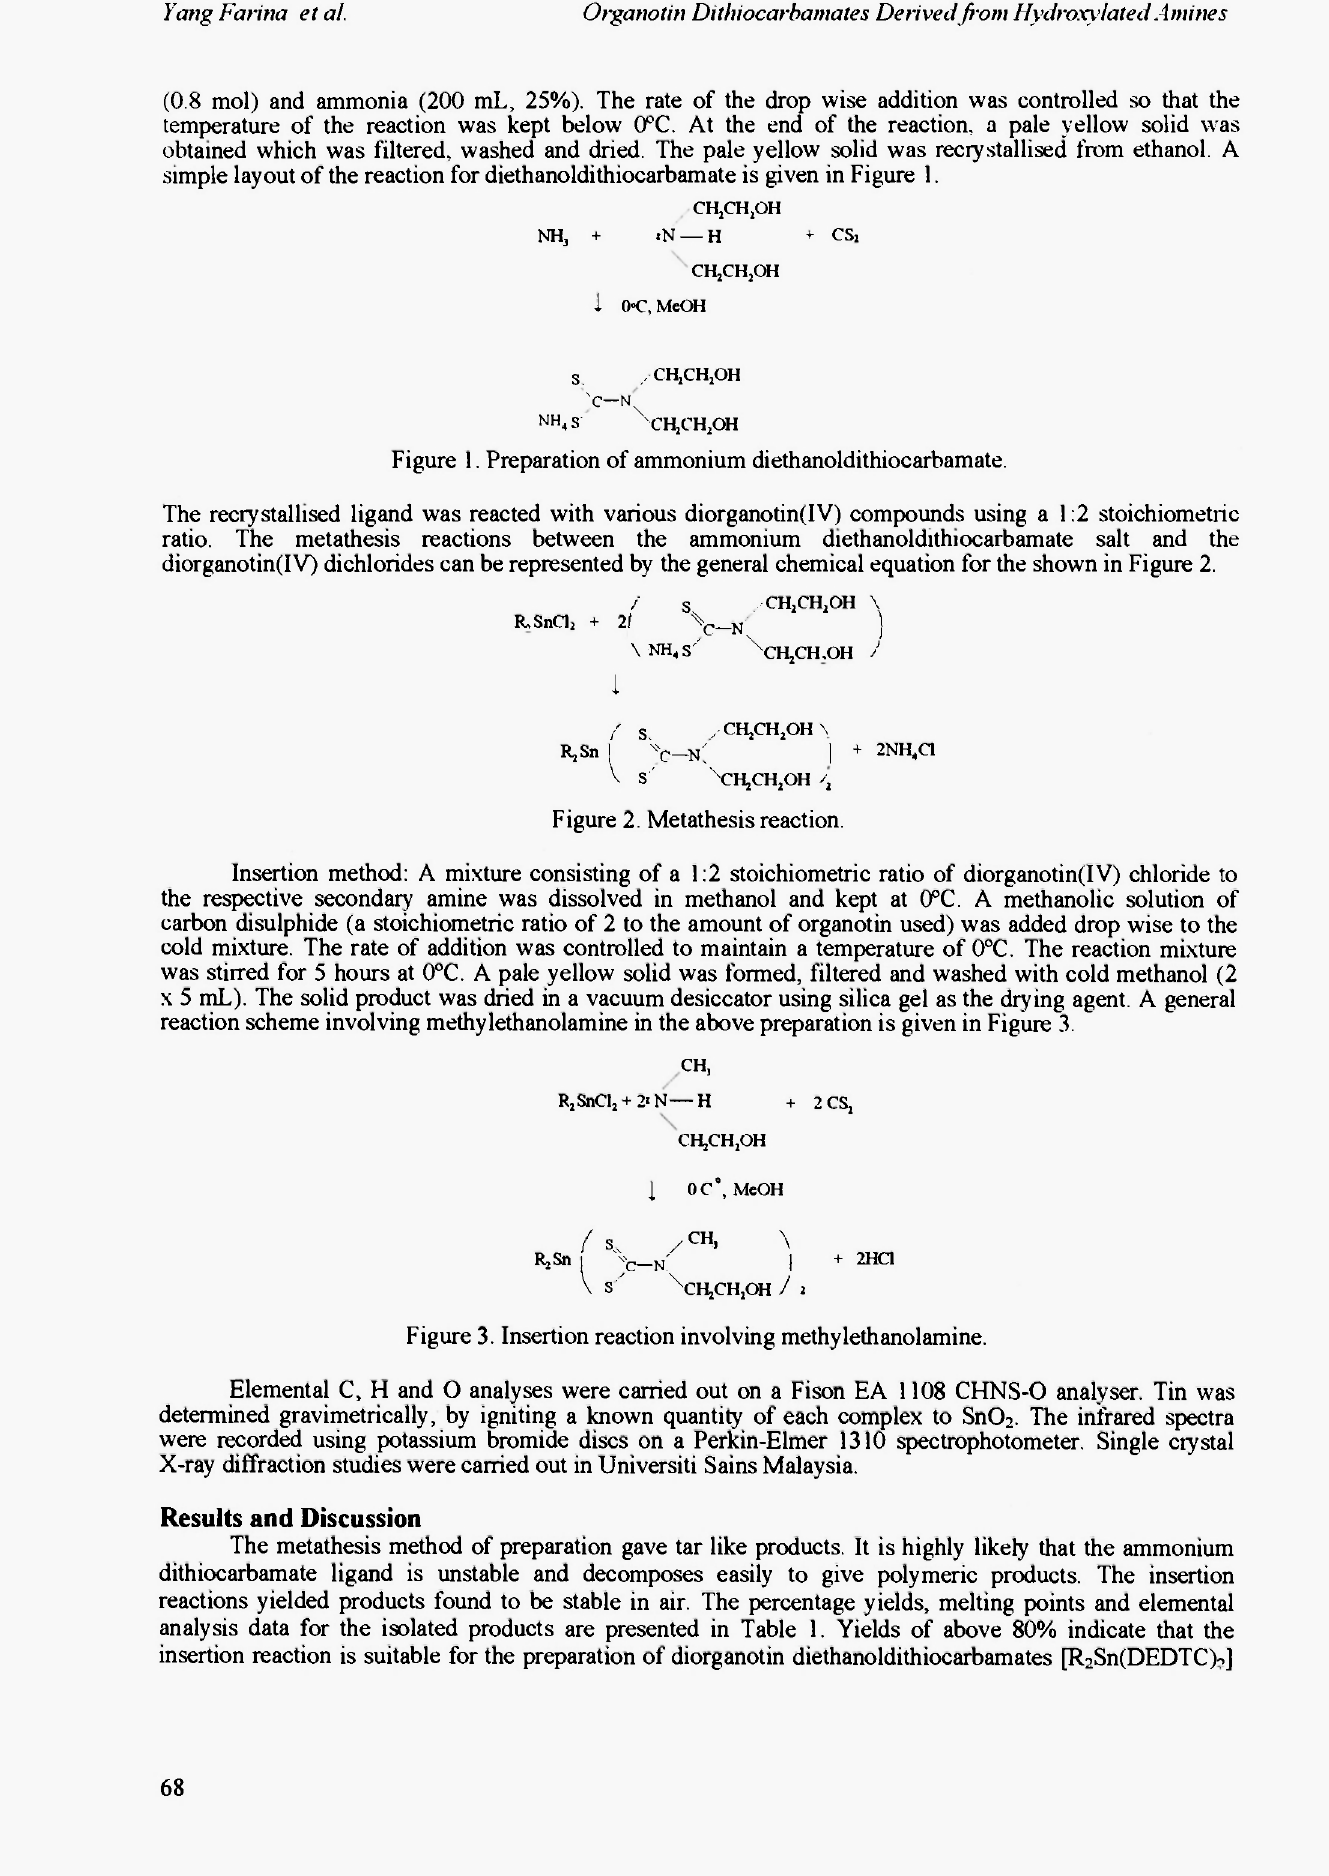
Figure 1. Preparation of ammonium diethanoldithiocarbamate.